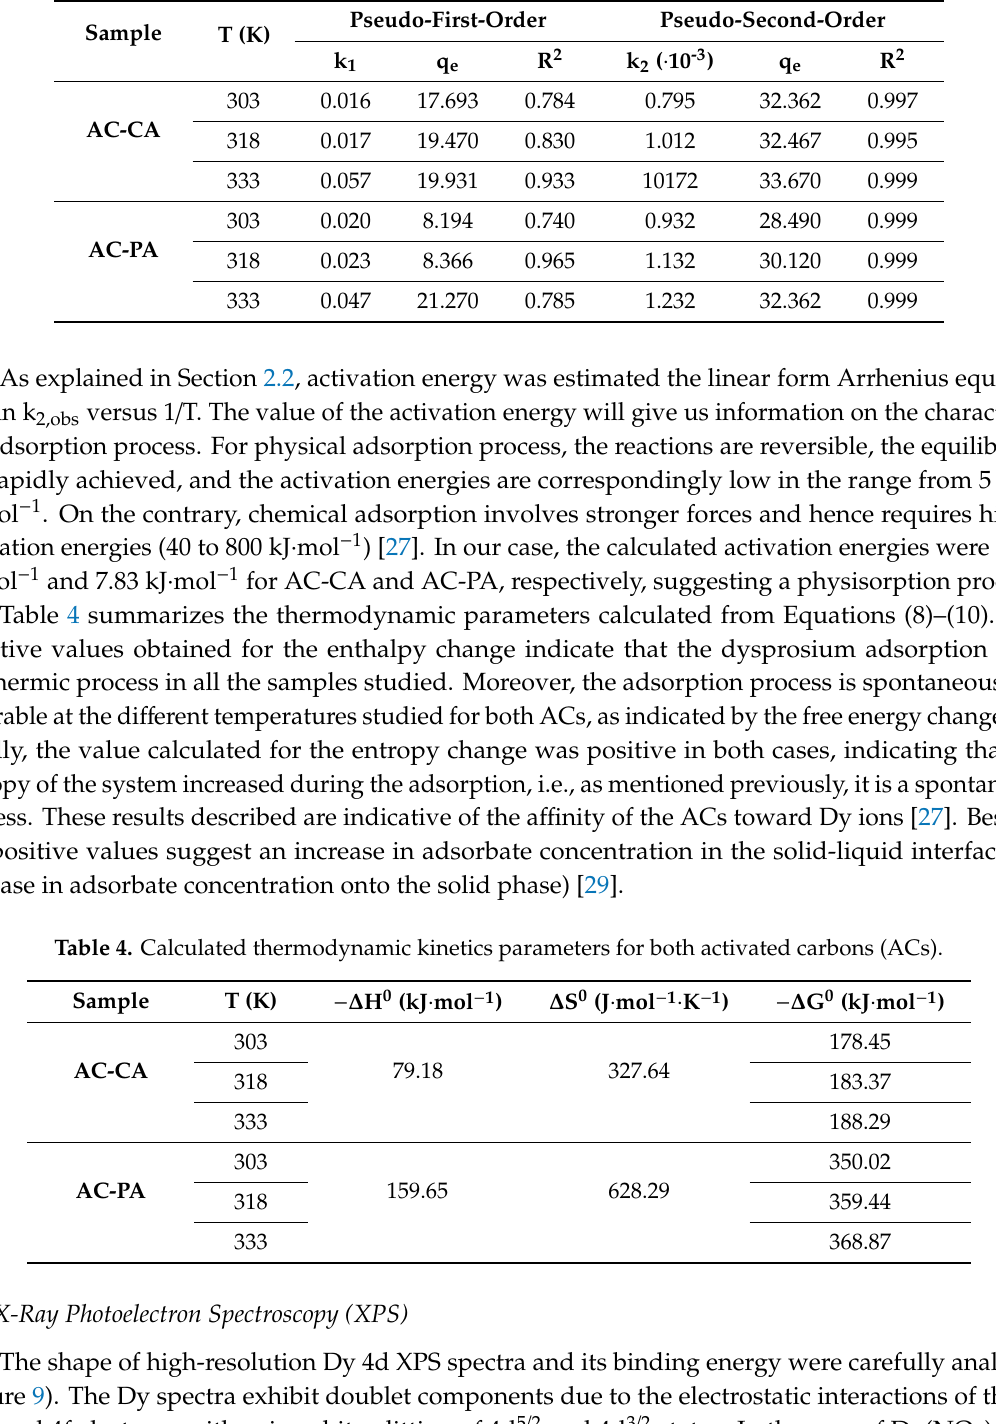
Table 3. Calculated kinetics parameters at di ff erent temperatures.